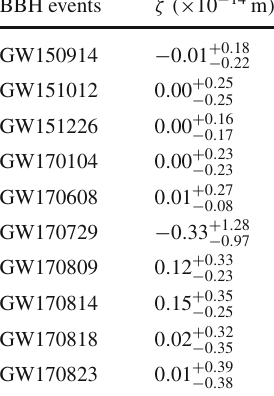
Table 1 Same caption as Fig. 2. Typically, we report the stringent constraints as | ζ | (cid:2) few × 10 − 15 m. The strictest limit is given by GW151226 [37].